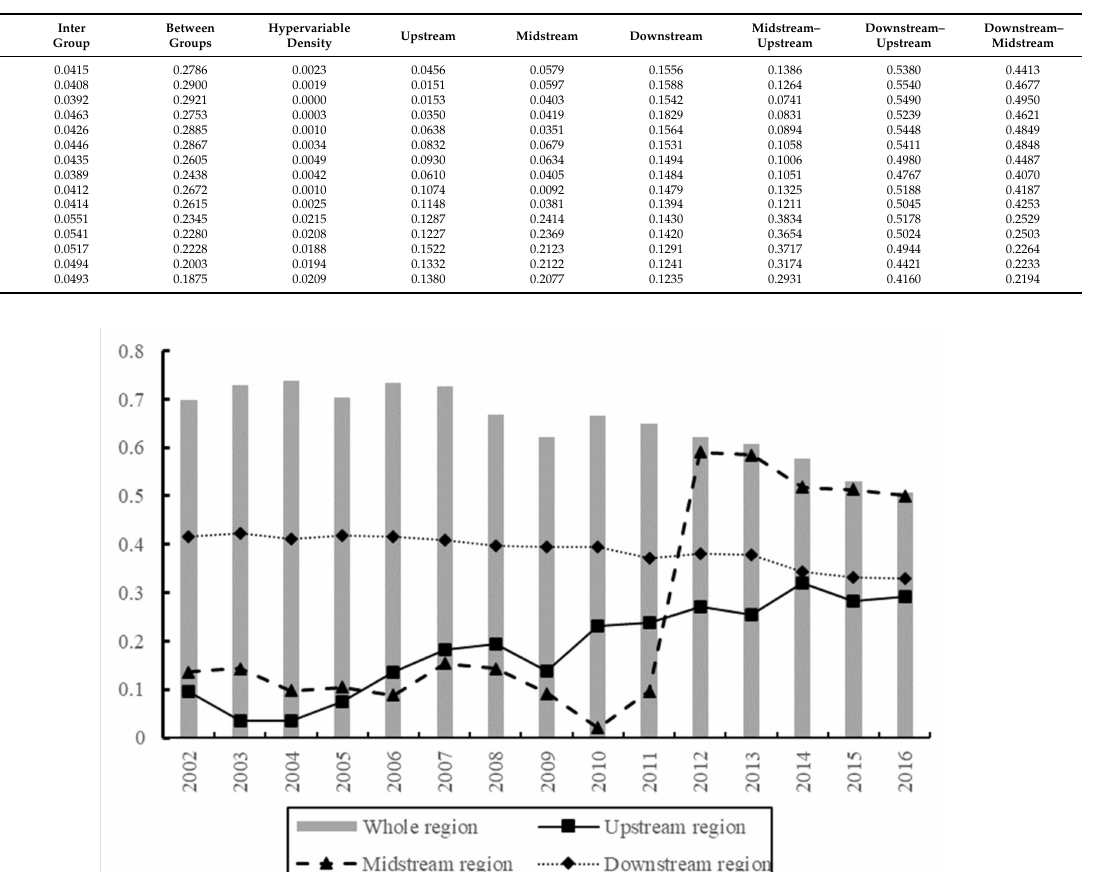
Table 3. Regional differences in green development efficiency of the chemical industry in the Yangtze River Economic Belt.